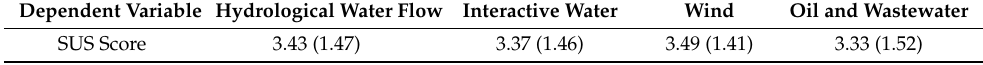
Table 2. Mean SUS scores for the four simulations on SUS (standard deviation in parentheses). Dependent Variable Hydrological Water Flow Interactive Water